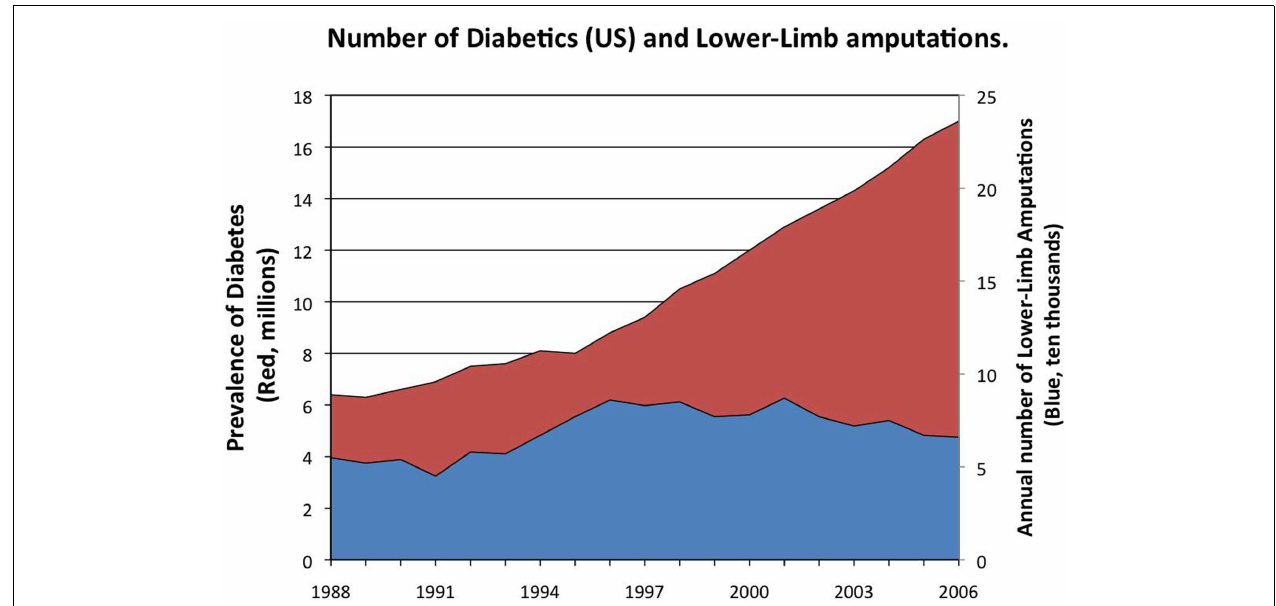
biofilm-associated infections and their sequelae greatly contribute to the healthcare cost for diabetic patients; as much as $174 billion is spent annually on diabetes in the United States (Mikkelsen et al., 2011).With almost 26 million diabetics (8.3% of the population) in the US currently and the number expected to rise, the number of these life-threatening infections is likely to increase.